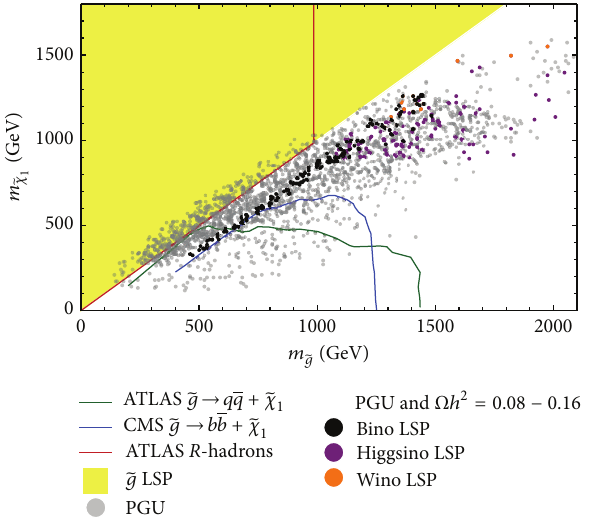
Figure 5: This is the same as Figure 3 but with the information on the dark matter candidates and abundance. The grey dots do not provide the correct relic density. Black dots correspond to an LSP that is predominantly bino, while purple (orange) dots correspond to higgsino (wino) LSP. The black dots are approximately aligned in a “coannihilation strip.”